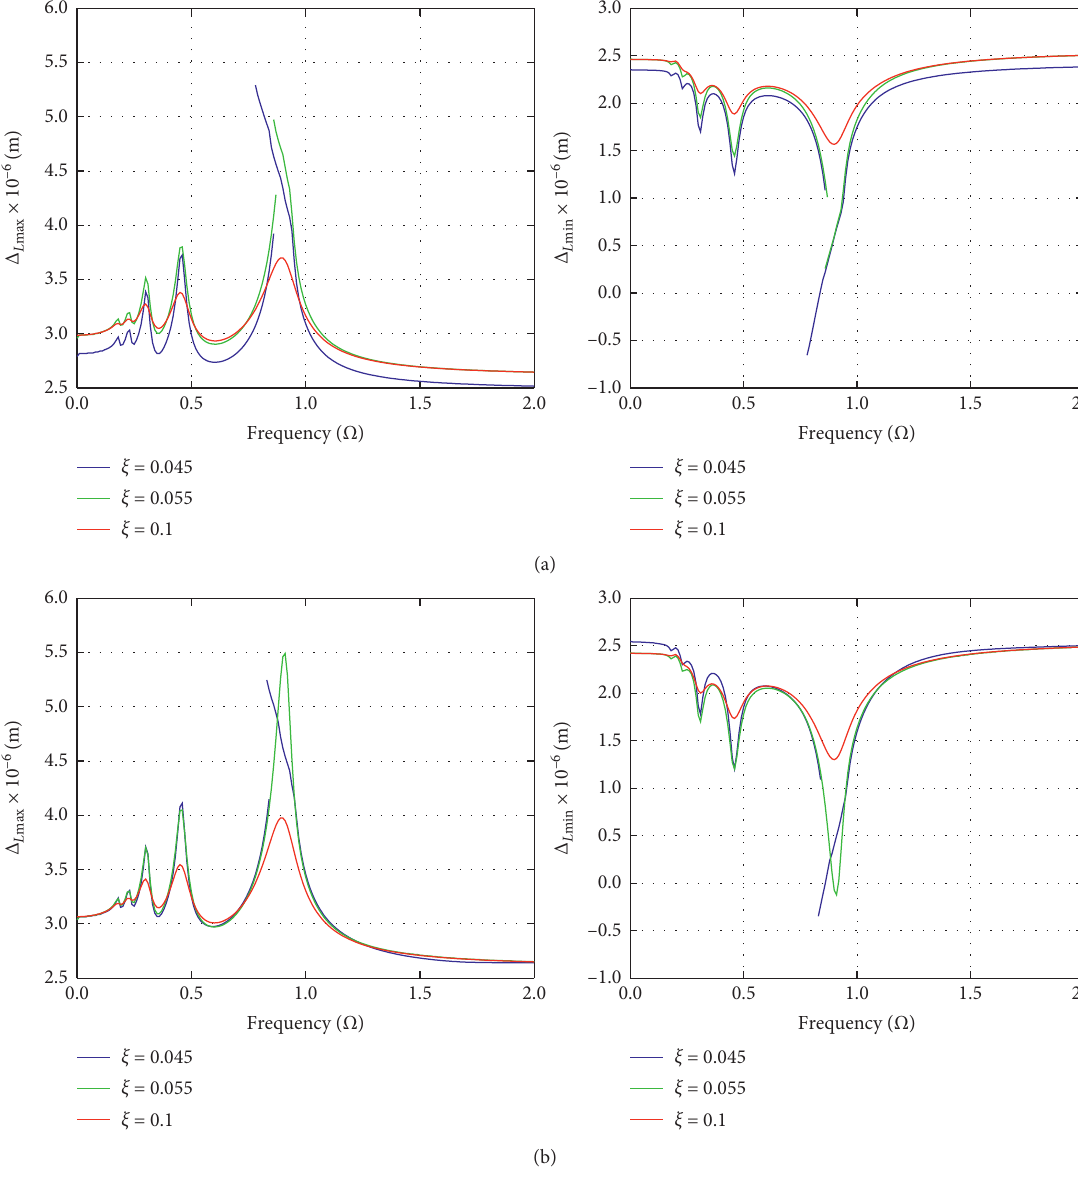
Figure 10: Influence of damping on amplitude frequency characteristic curve of the system. (a) Constant backlash models and (b) dynamic backlash